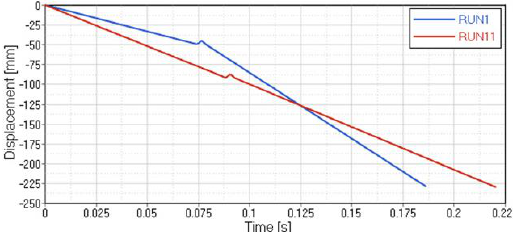
Figure 15. Reaction force curves comparison between RUN1 and RUN11; blank1.